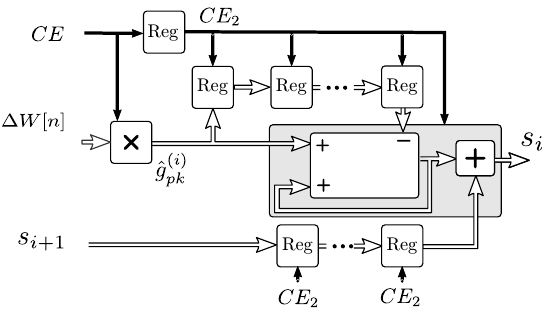
Figure 10. Implementation of each sub-filter in the second segment of the thermal